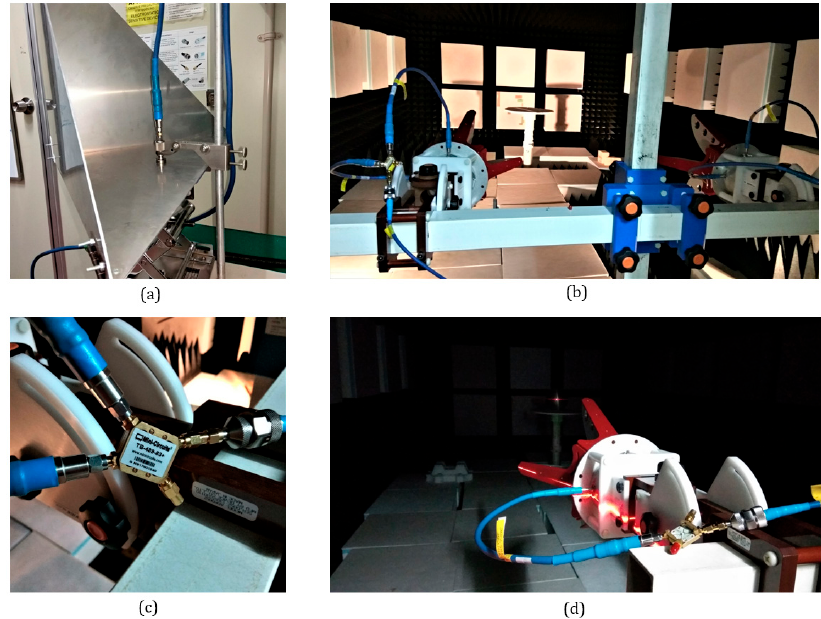
Figure 8. Some activities that took place during the experiment: ( a ) Measuring the target material’s dielectric constant, ( b ) after the antenna and the phase shifter installation, ( c ) the phase shifter, and ( d ) antenna–target horizontal alignment using a laser liner.